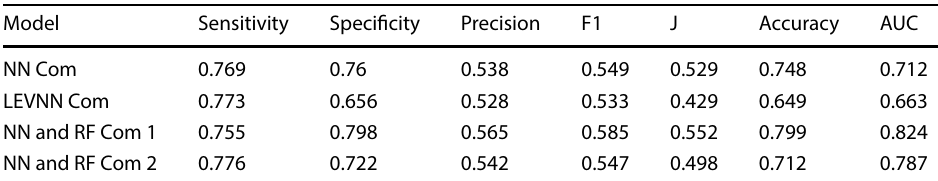
Table 11 Combined classifiers (testing)